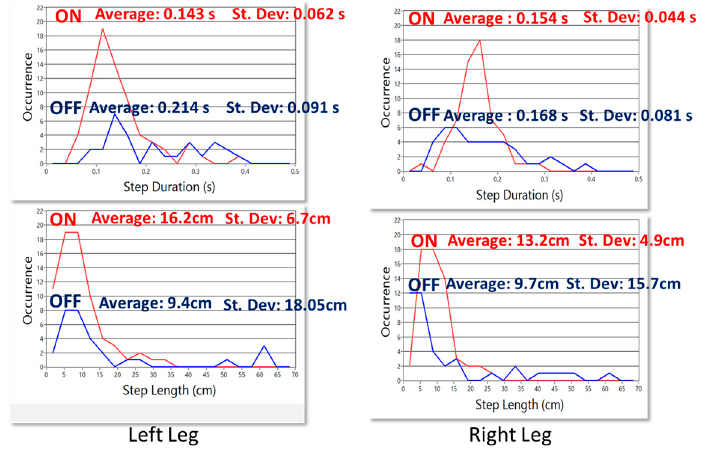
Figure 5. Step features 60’ before (OFF) and 60’ after (ON) the drug